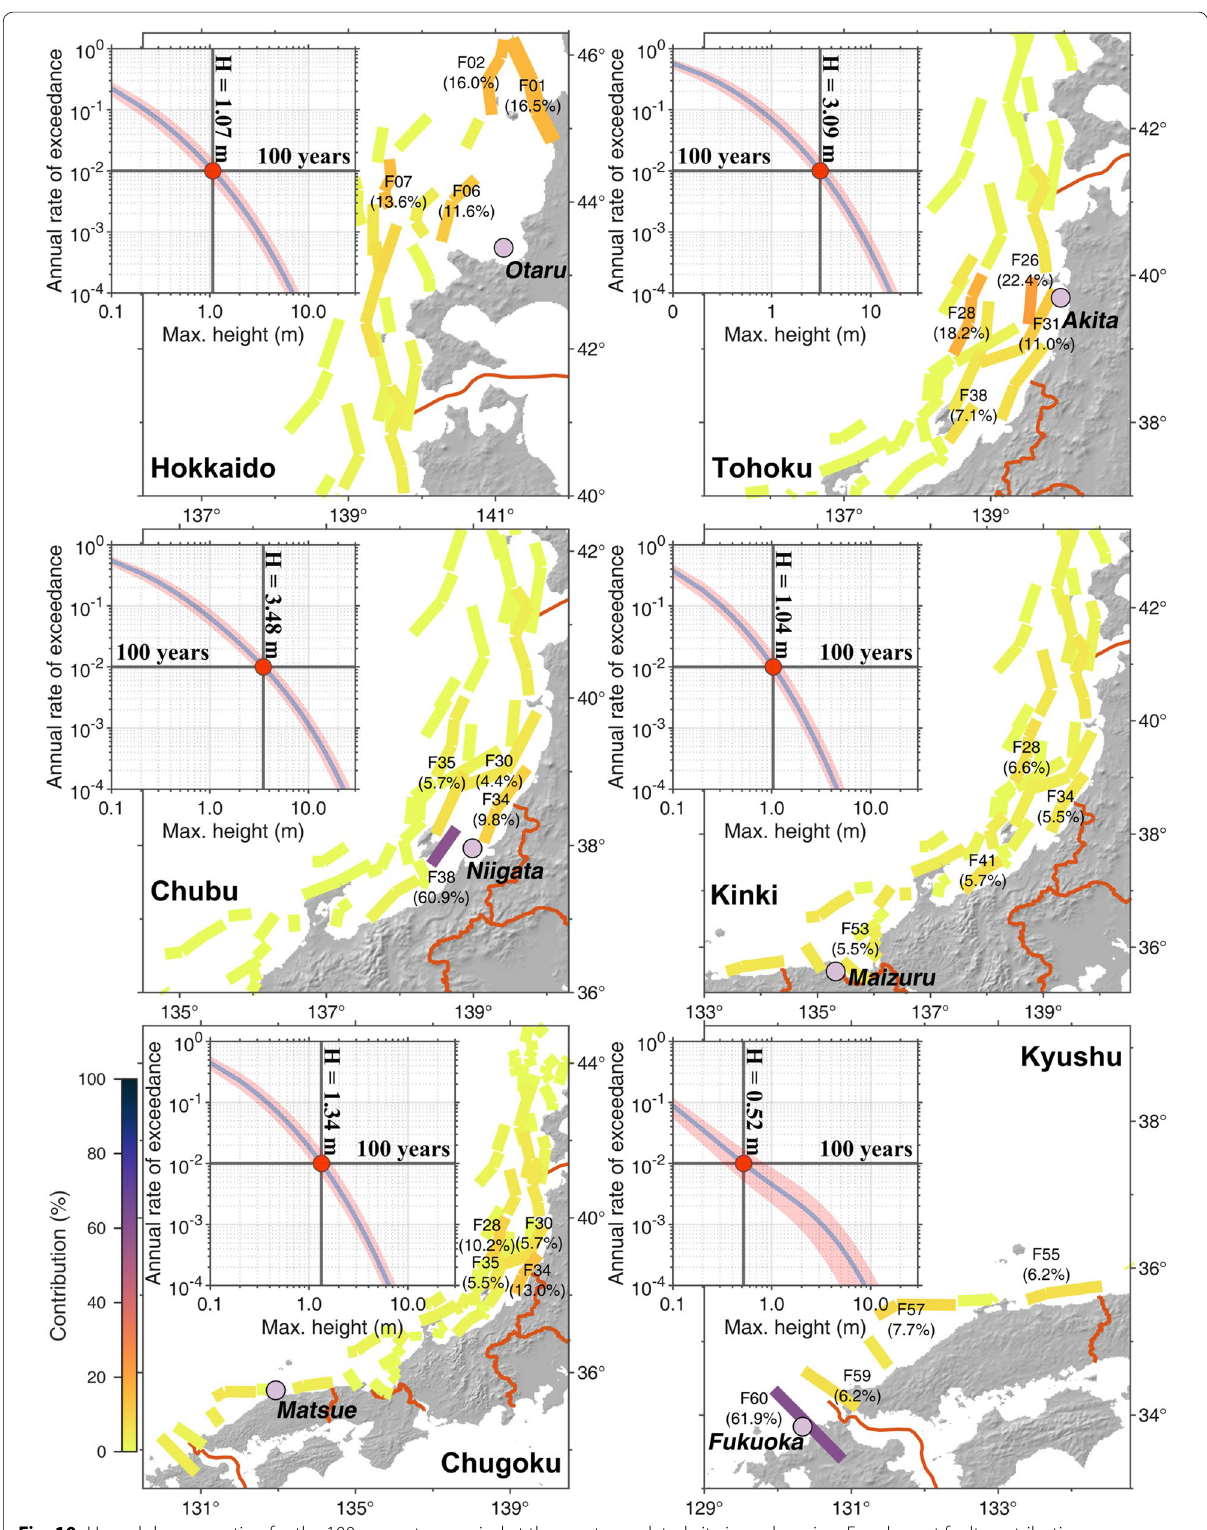
Fig. 10 Hazard deaggregation for the 100-year return period at the most populated city in each region. Four largest fault contributions are annotated in the map. Insets show the corresponding tsunami hazard curve with uncertainty ranges between 15th and 85th percentile. Red lines mark region boundaries. We fix the fault width for visual